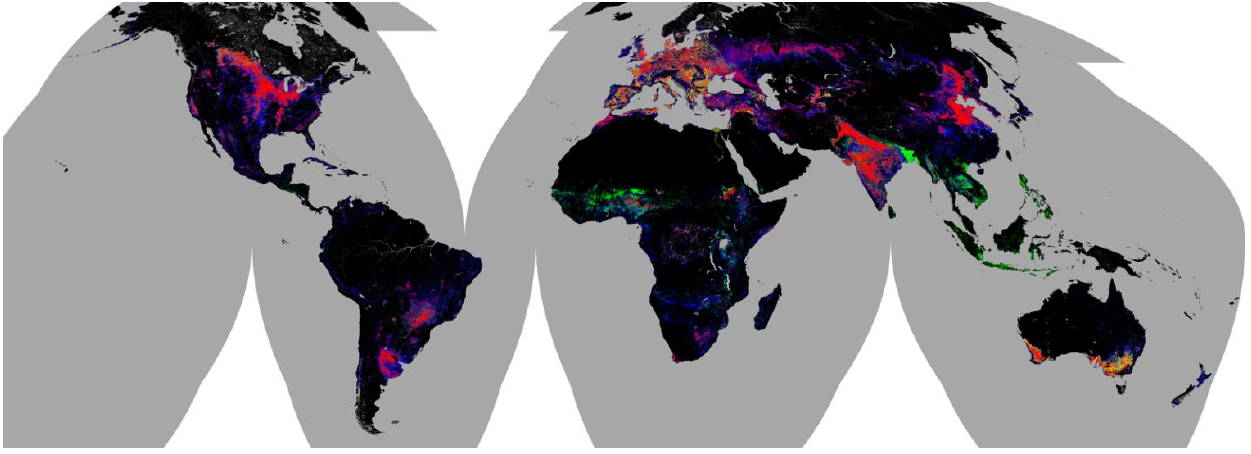
Figure 2. Comparison of cropland extent derived from a single global matching threshold versus per country matching thresholds where red equals global/national cropland (>=43%), orange equals global/not national cropland (>=43%), green equals not global/national cropland (<43%), and blue equals not global/not national cropland (>0% and <43%). Black equals no indicated